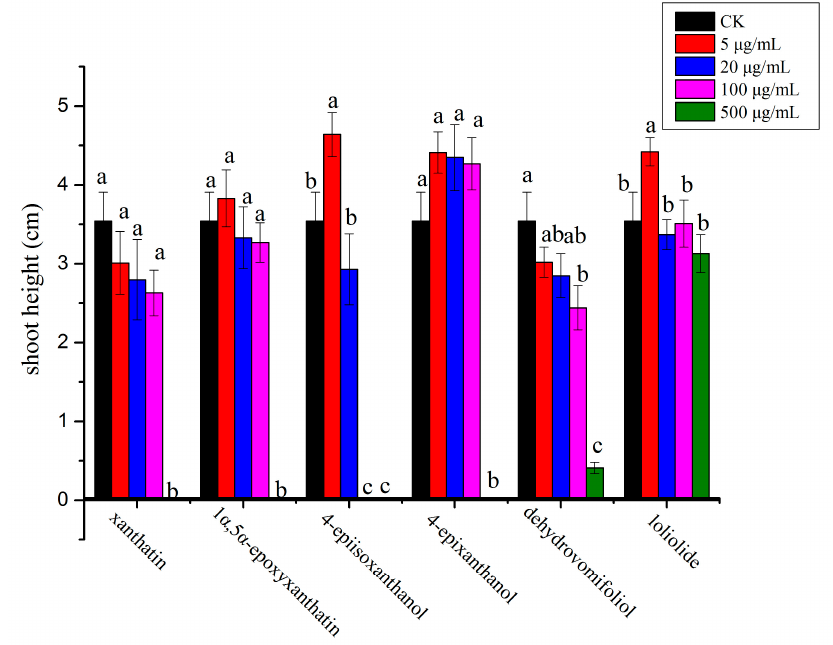
Figure 5. Phytotoxic effect of isolated compounds on shoot growth of P. annua . Different letters represent a significant difference at p < 0.05 level according to Fisher’s LSD test.